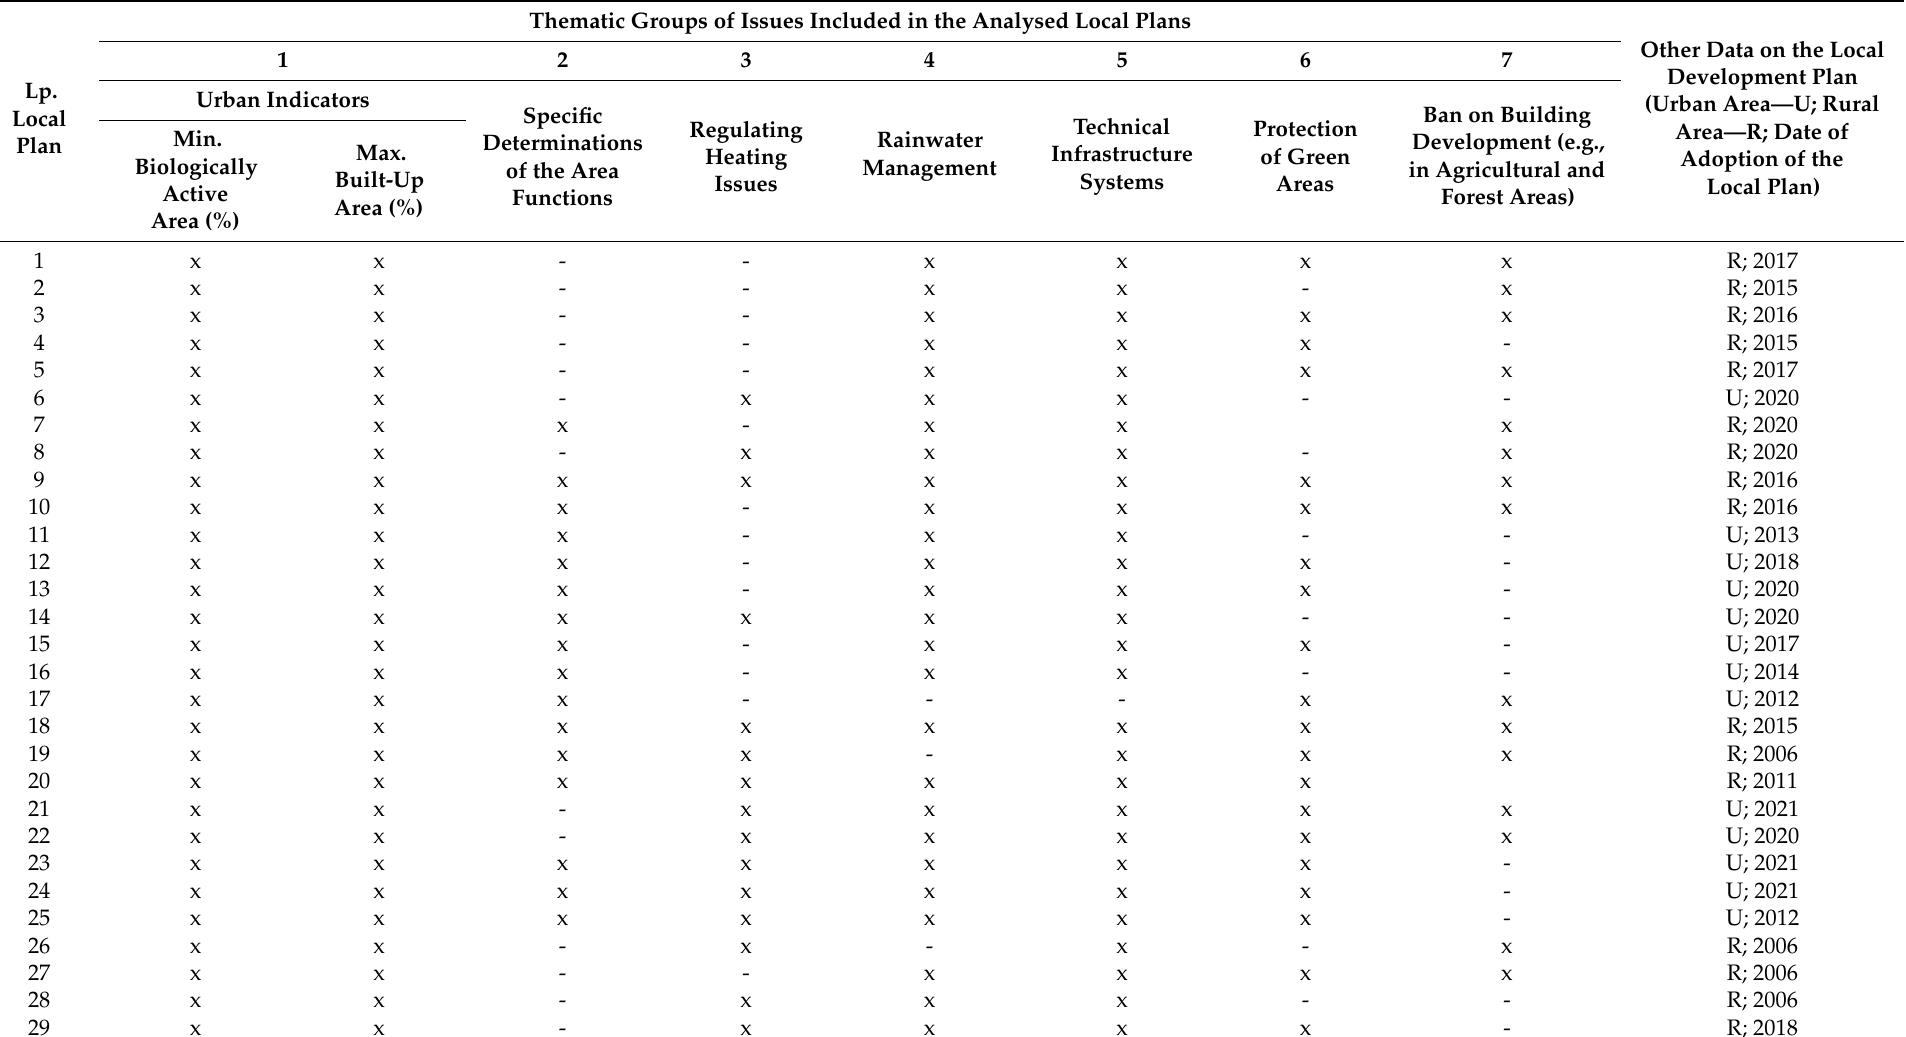
Table 2. Summary of results from the analysis of planning provisions used in selected local spatial development plans in the context of possible prevention of the effects of climate change 2 .